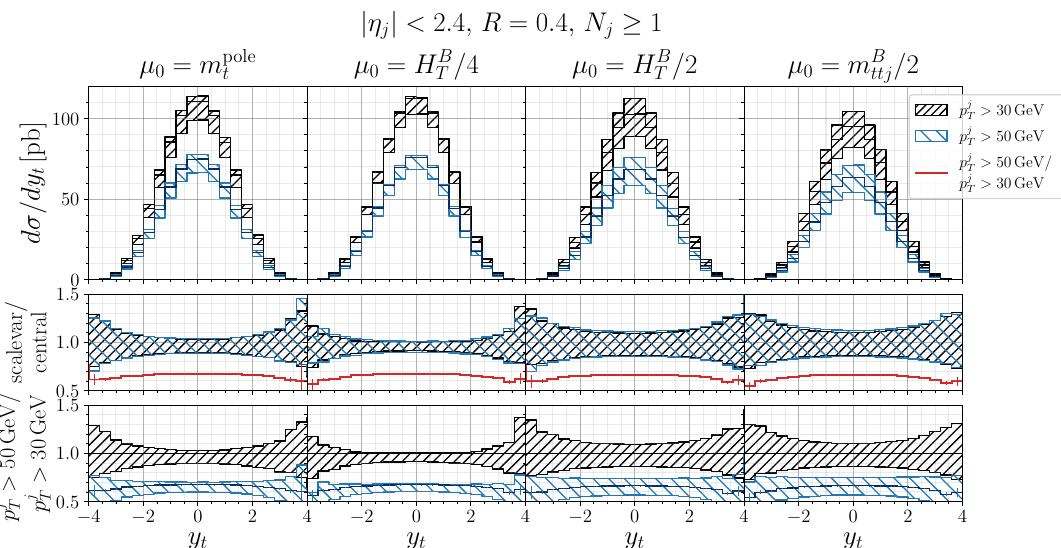
Figure 12 . NLO central predictions for the y t distribution with a p j and 50 GeV (blue), accompanied by the corresponding seven-point scale variation uncertainty bands, obtained using as a central scale µ 0 = m t , H B middle ratio plot the scale variation uncertainty band with either p j scale prediction with the same analysis cut. To visualize the difference between the differential cross section obtained with the different p j in red. In the bottom ratio plot the scale variation uncertainty bands using either analysis cut are rescaled by the central scale result using the requirement p j